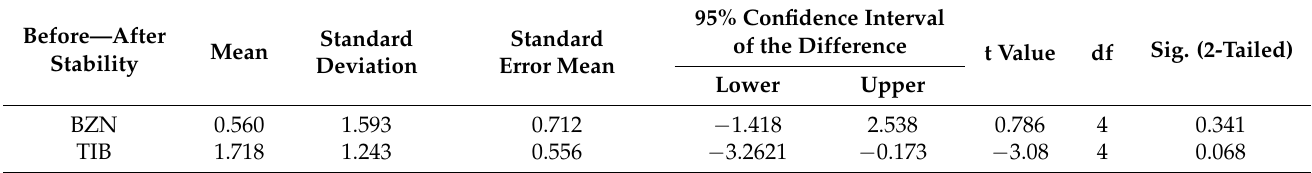
Table 3. Statistical analysis of the optimized formulation after the stability conditions.